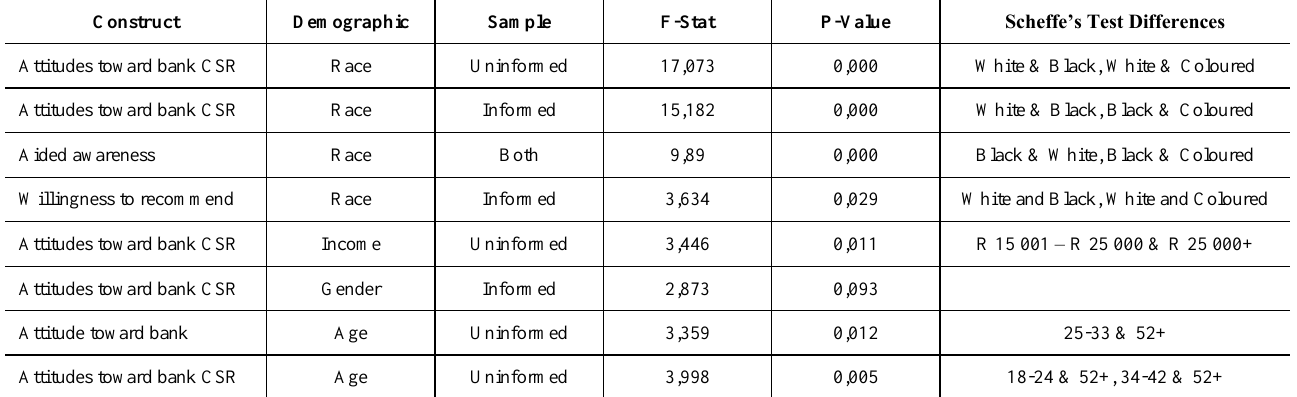
Table 7: Selected demographic ANOVAs Construct